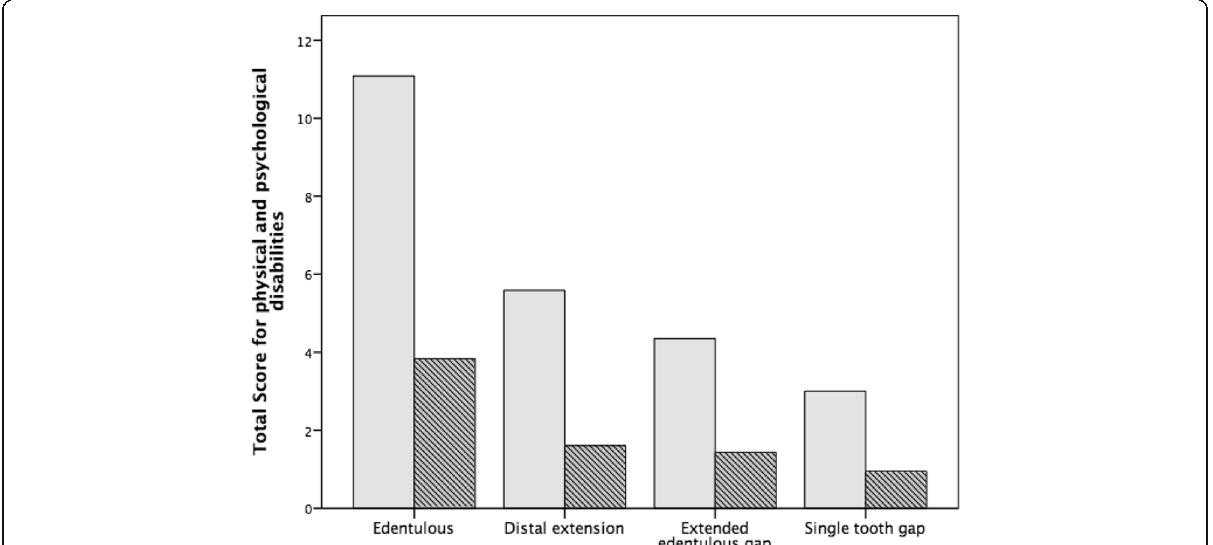
Fig. 5 Total score for physical and psychological disabilities before ( gray ) and after (hatched) sinus augmentation according to